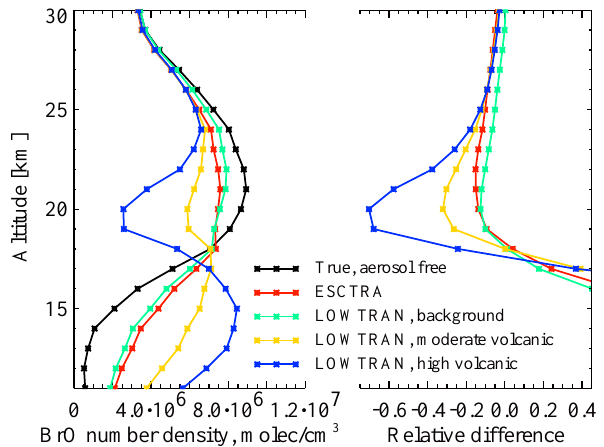
Fig. 18. Same as in Fig. 17 but for a typical observation over North Western Brasil during tropical